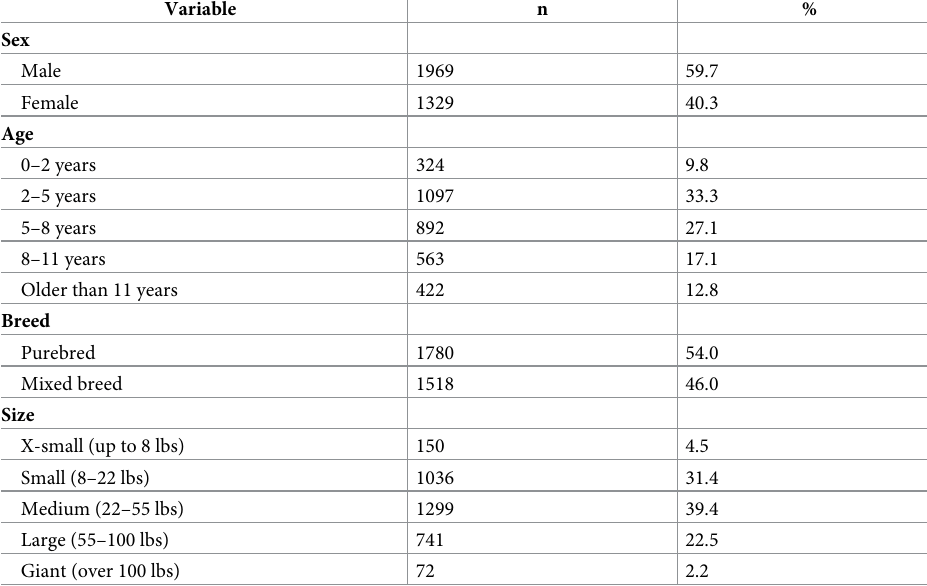
Table 2. Demographic data, including sex, age, breed and size for all dogs (n = 3,